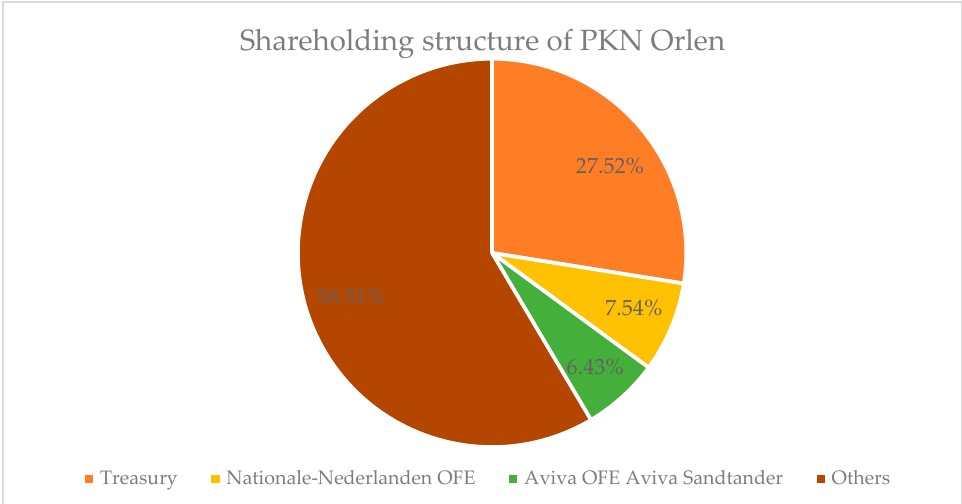
Figure 5. PKN Orlen’s shareholding structure—situation as of 15 March 2022. Source: authors’ own studies, developed from [60].